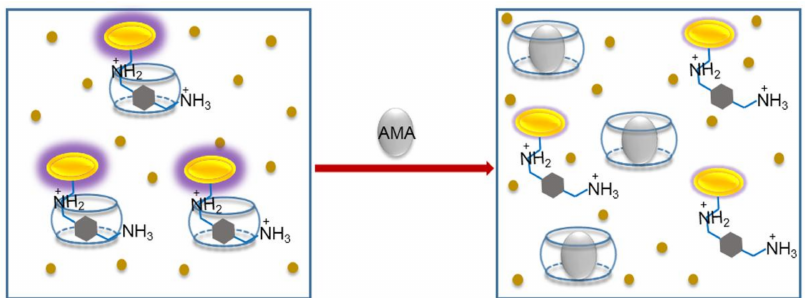
Scheme 1. Schematic representation of the principle of indicator displacement assay for the detection of AMA using the complex CB[7] · ABAM as a fluorescent probe.